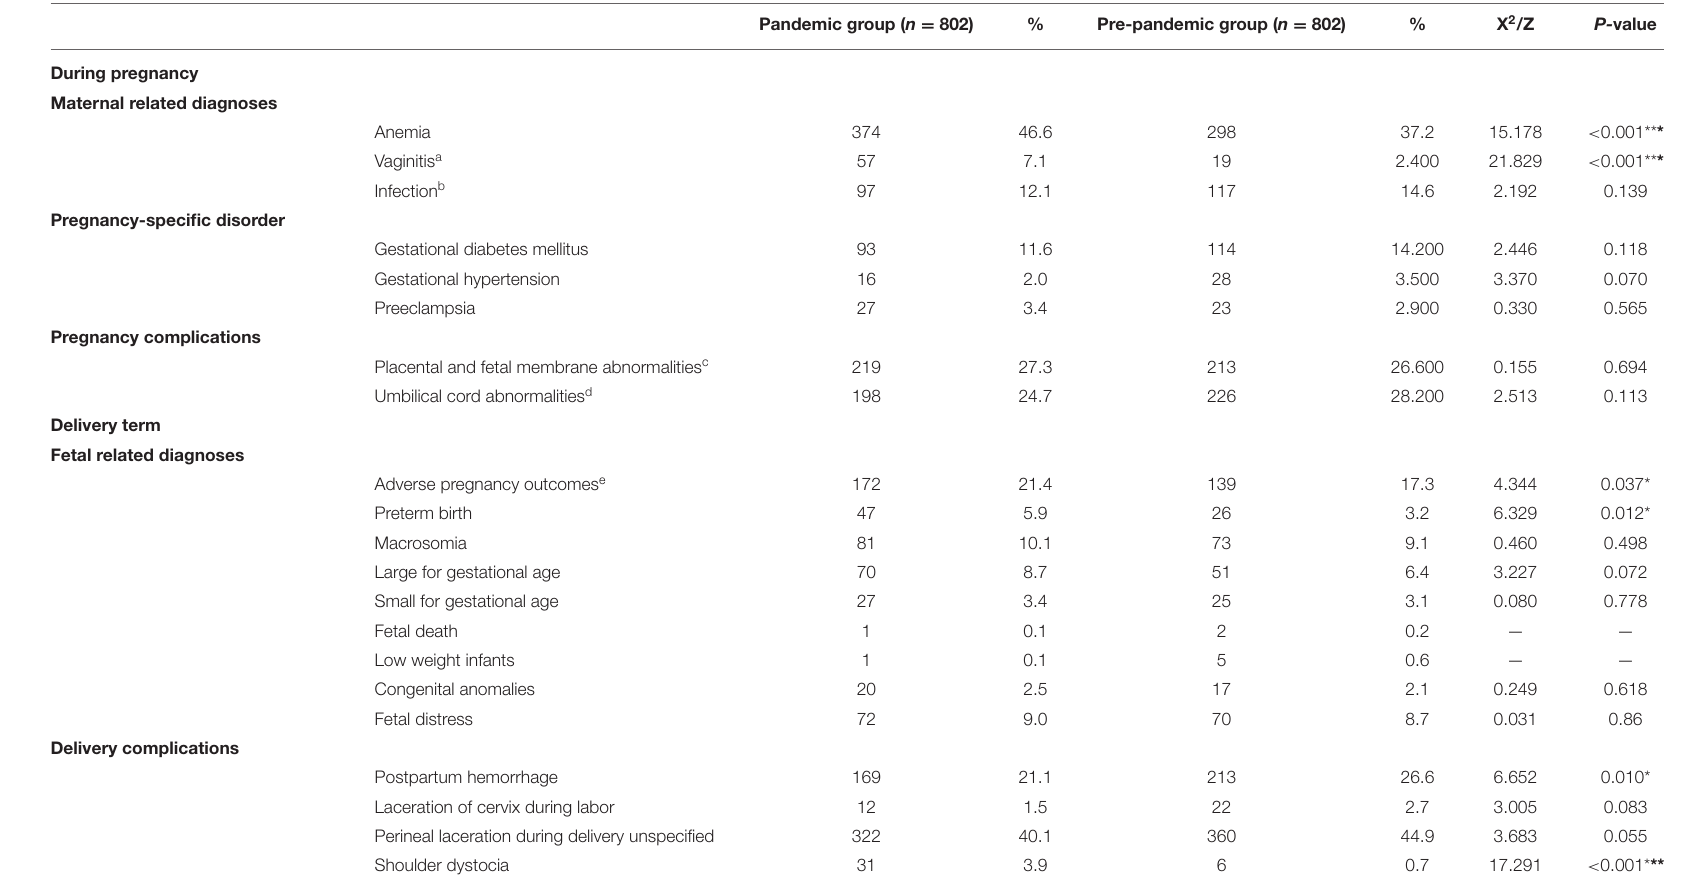
TABLE 2 | Pregnancy outcomes before and during the COVID-19 pandemic, China, 2018-2020. Pandemic group ( n = 802) % Pre-pandemic group ( n = 802) % X 2 /Z P-